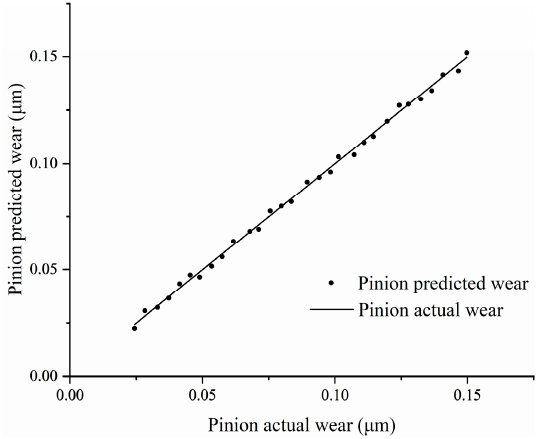
Figure 8. Actual wear depth and prediction based on Kriging model.